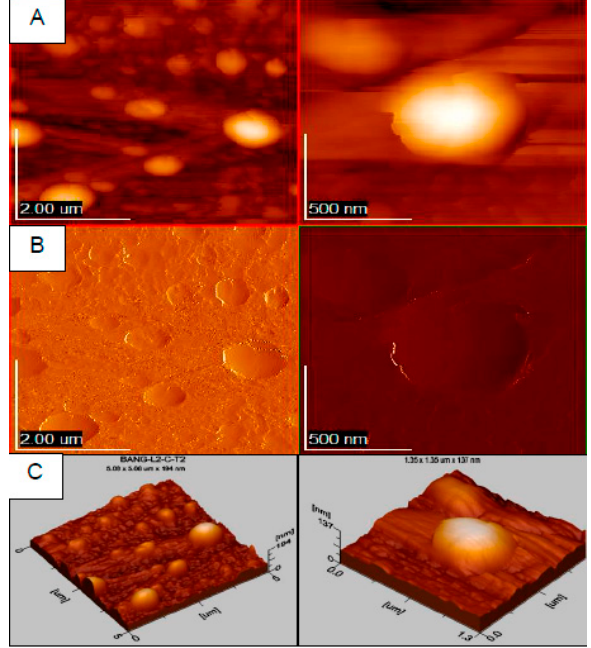
Figure 11. Atomic force microscopy (AFM) microscopy of curcumin poly- ε -caprolactone nanoparticles in two magnifications, left and right. Images in AFM ( A ), 2D ( B ) and 3D ( C ) mode.